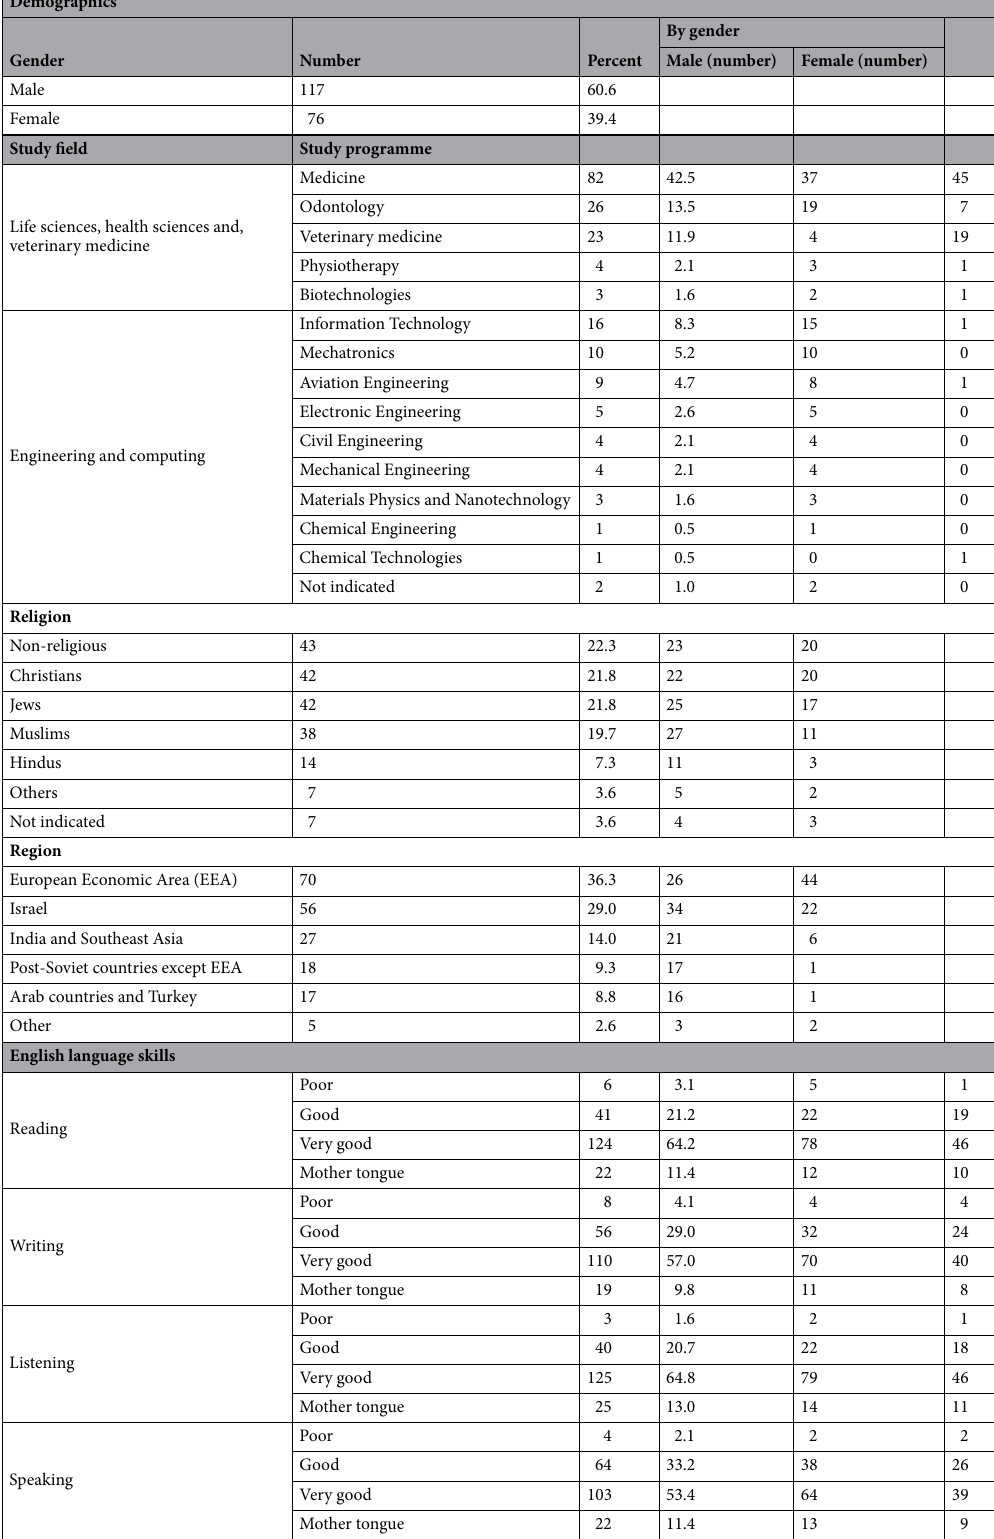
Table 1. Main characteristics of study